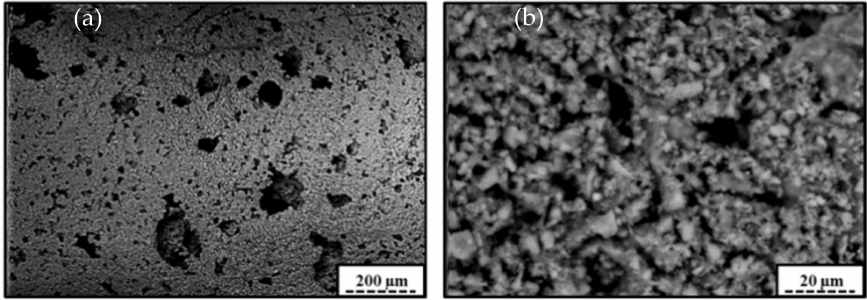
Figure 12. Picture of sample G: ( a ) magnification of 100 × , ( b ) magnification of 1000 × .